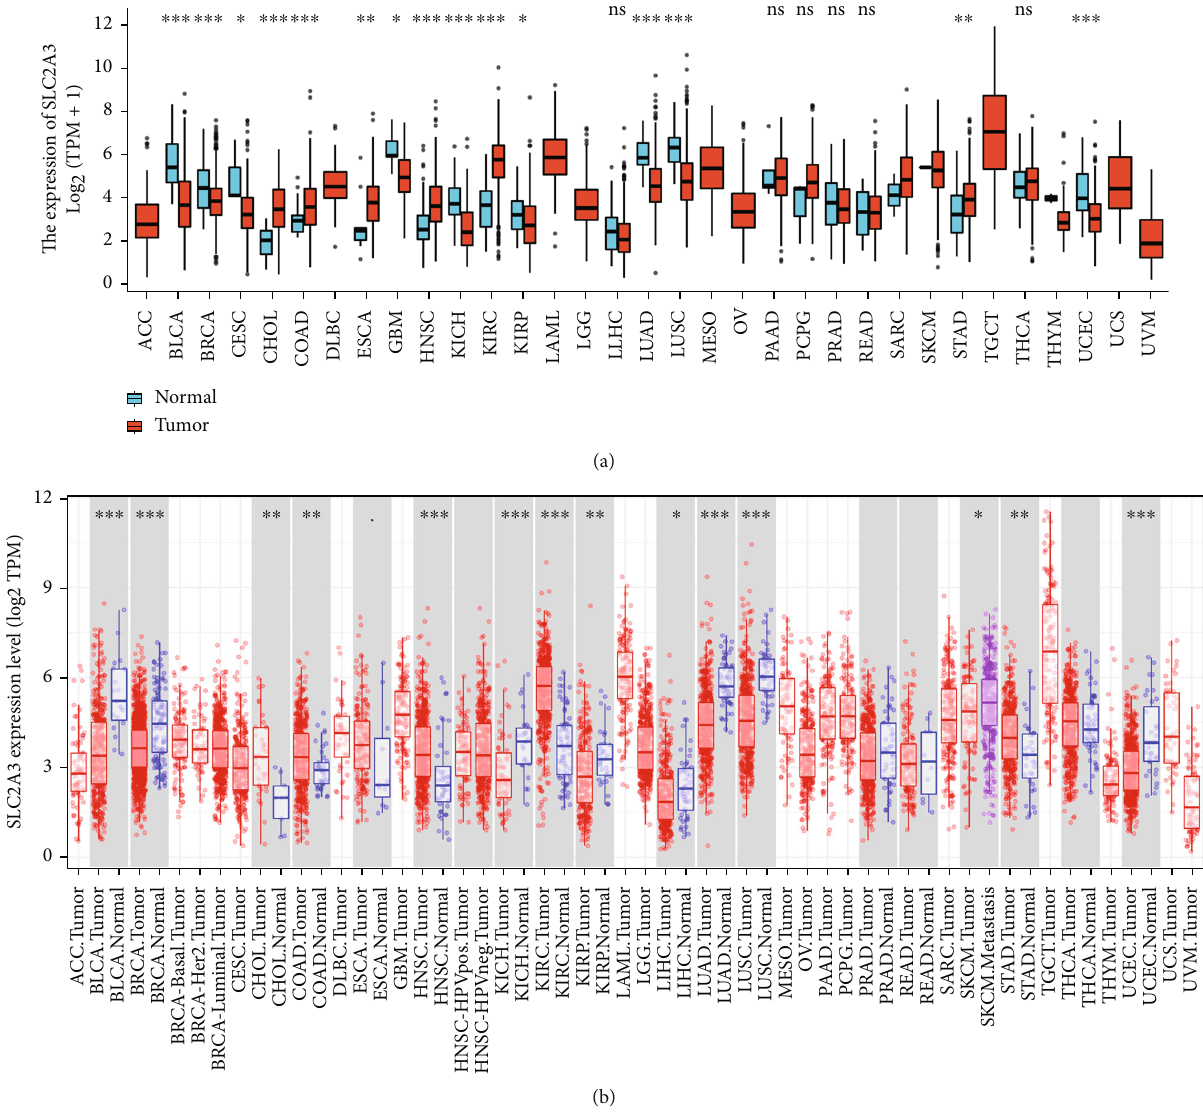
Figure 1: SLC2A3 expression levels in human cancers determined using R software (a) and TIMER database (b). (ns, no signi fi cance, ∗ P < 0 : 05 , ∗∗ P < 0 : 01 , ∗∗∗ P < 0 : 001